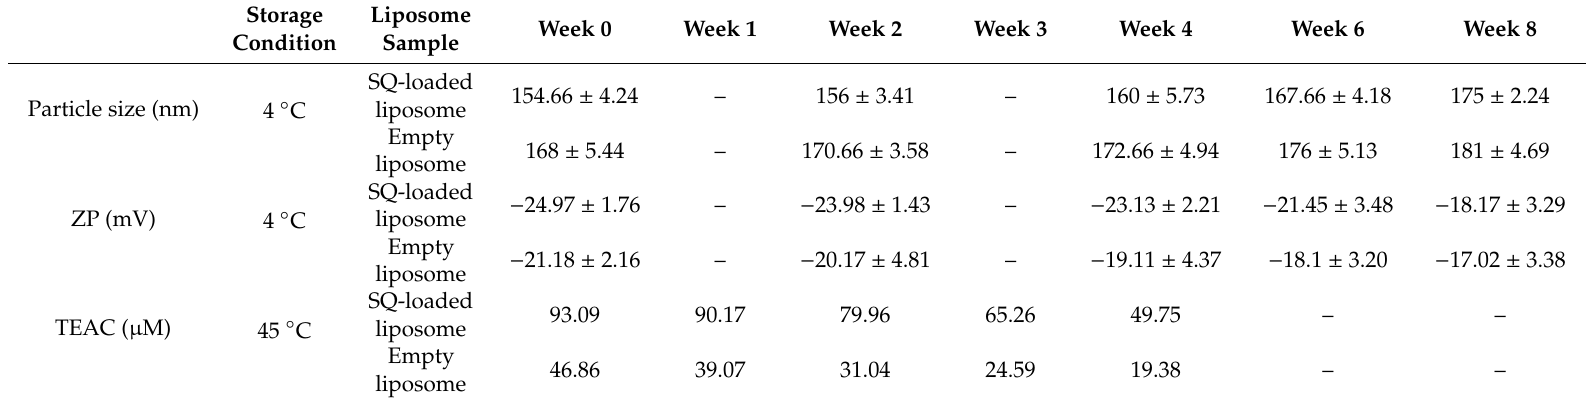
Table 6. Changes in the particle size, zeta potential (ZP) and trolox equivalent antioxidant capacity (TEAC) of the optimized squalene (SQ)-loaded and free (empty) liposomes after the storage